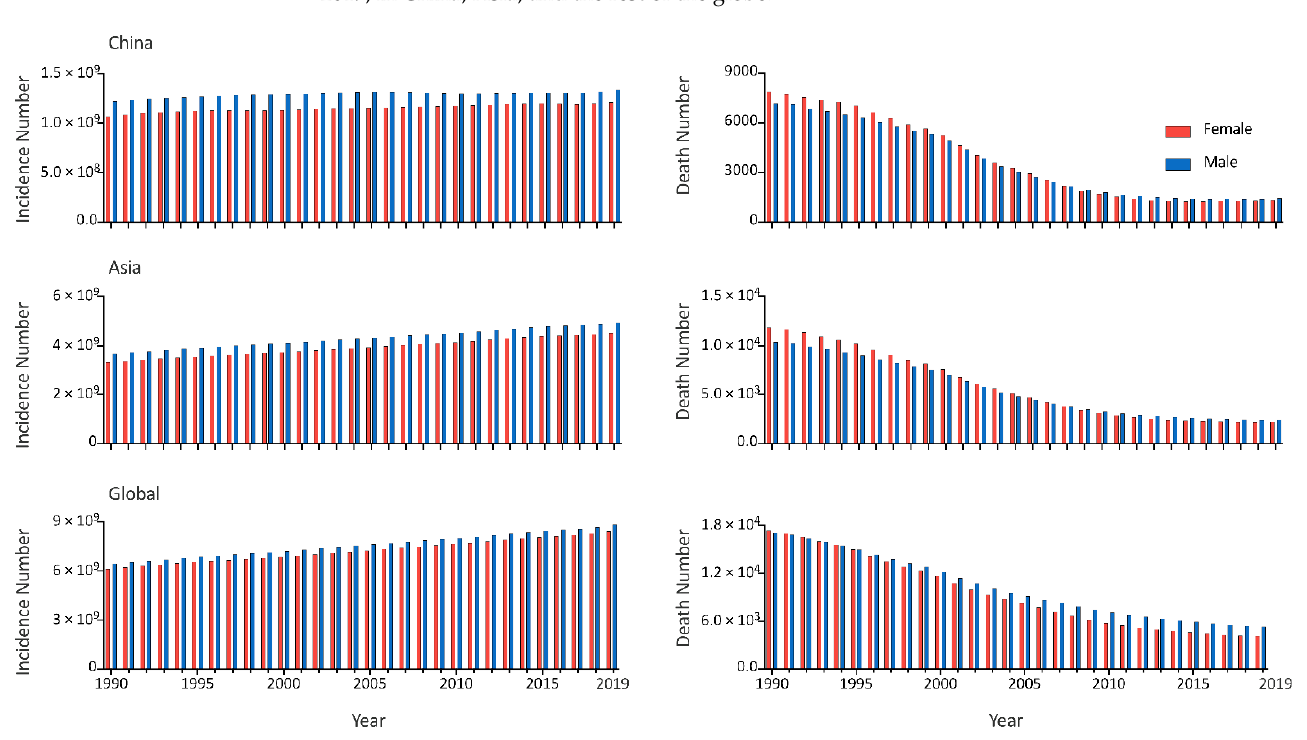
Figure 3. The number of upper respiratory infection cases and deaths by sex, from 1990 to 2019, in China, Asia, and the rest of the globe.